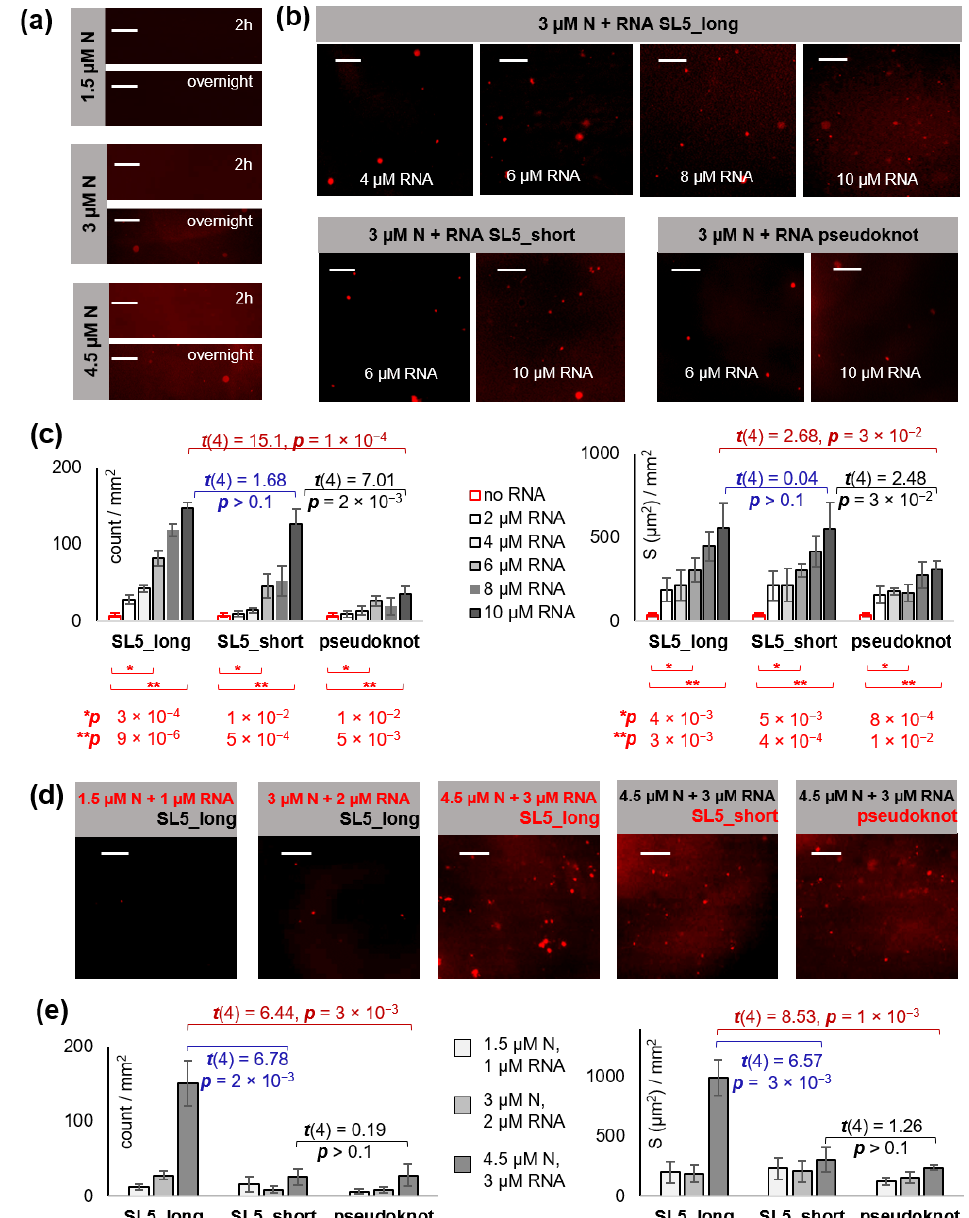
Figure 2. N-RNA phase separation under pseudo-physiological conditions: dependence on RNA structure and concentration. ( a ) N separation in the absence of RNA. Fluorescence microscopy images were obtained after incubation of RED-labeled N (1.5 – 4.5 µM) in the working buffer (20 mM Tris-HCl buffer, pH 7.4) at 37 °C for 2 h or overnight. ( b ) RNA effects on the separation of 3 µM N. The images of N mixtures with increasing RNA concentrations were obtained after an overnight incubation in the working buffer at 37 °C. ( c ) Summary of RNA effects on the separation of 3 µM N. Left: Average number of droplets (count) per mm 2 coverslip. Right: average total droplet area (S, µm 2 ) per mm 2 coverslip. ( d ) RNA effects in 1.5:1 N:RNA mixtures. The images of the mixtures with increasing total concentrations were obtained after overnight incubation in the working buffer at 37 °C. ( e ) Summary of the separation of 1.5:1 N:RNA mixtures. Left: average droplet number (count) per mm 2 coverslip. Right: average total droplet area (S, µm 2 ) per mm 2 coverslip. Scale bars: 10 µm.